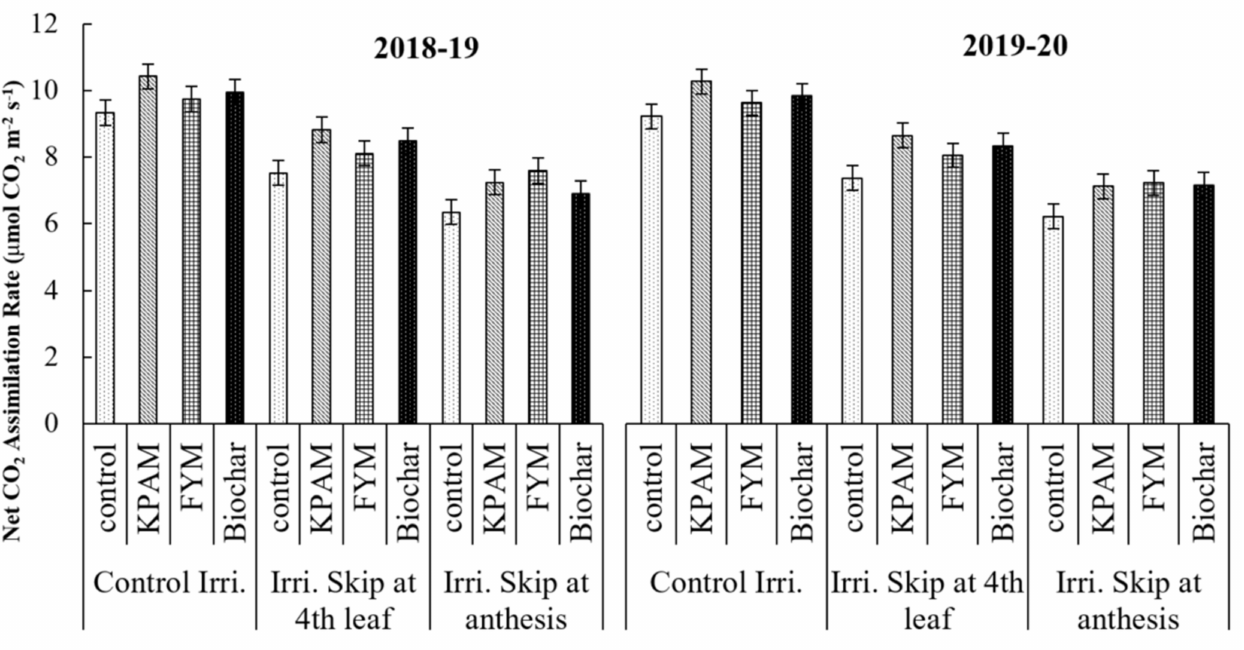
Figure 5. Effect of soil amendment materials on net CO 2 assimilation rate in the wheat crops grown under normal and water stress imposed by skipping irrigation at 4th leaf and anthesis stage of growth (mean values ±